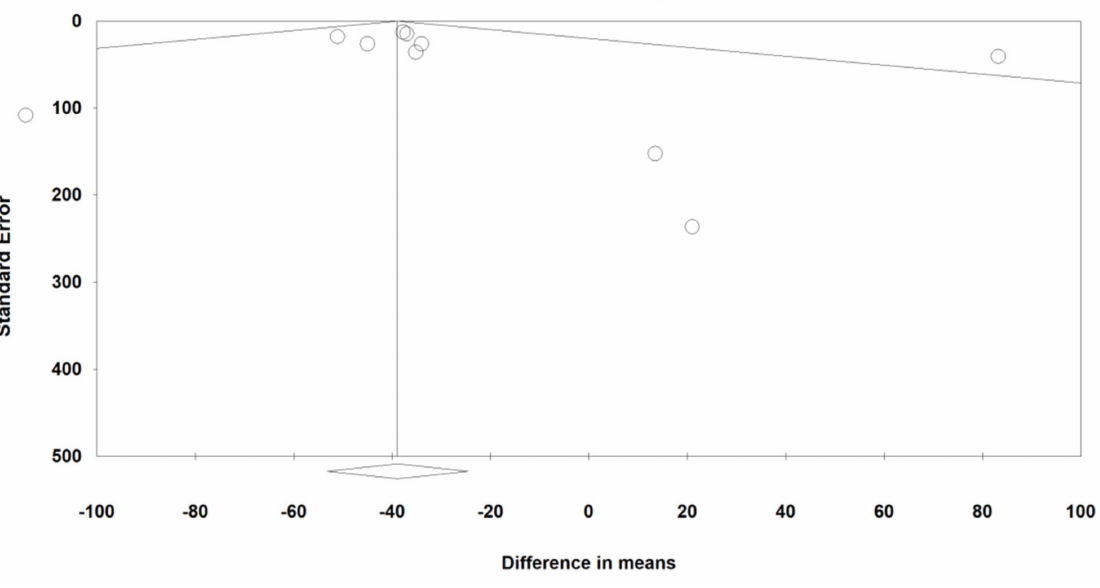
Figure 5. Funnel plot detailing publication bias in the publications describing the effect of statin treatment on serum ferritin